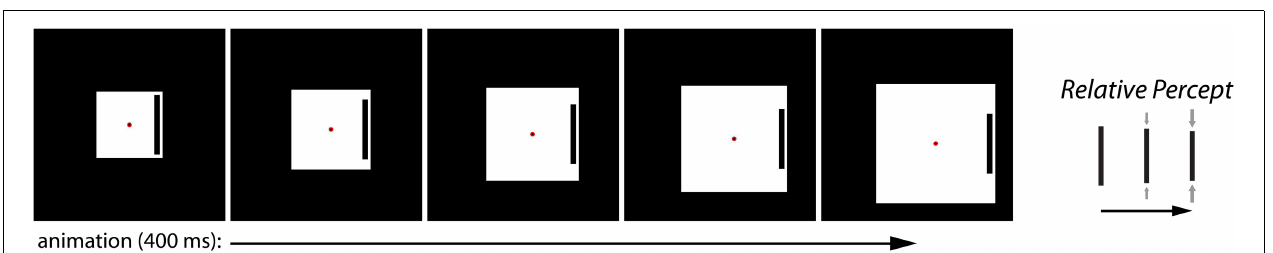
FIGURE 2 | The Dynamic Illusory Size Contrast (DISC) effect. The black target bar is perceived to be shrinking when a surrounding white box grows (right). The effect requires both the relative size change between the